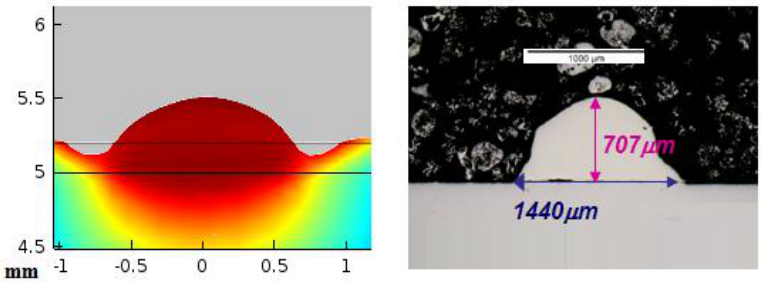
Figure 11. Theoretical ( left ) and experimental ( right ) cross sections.